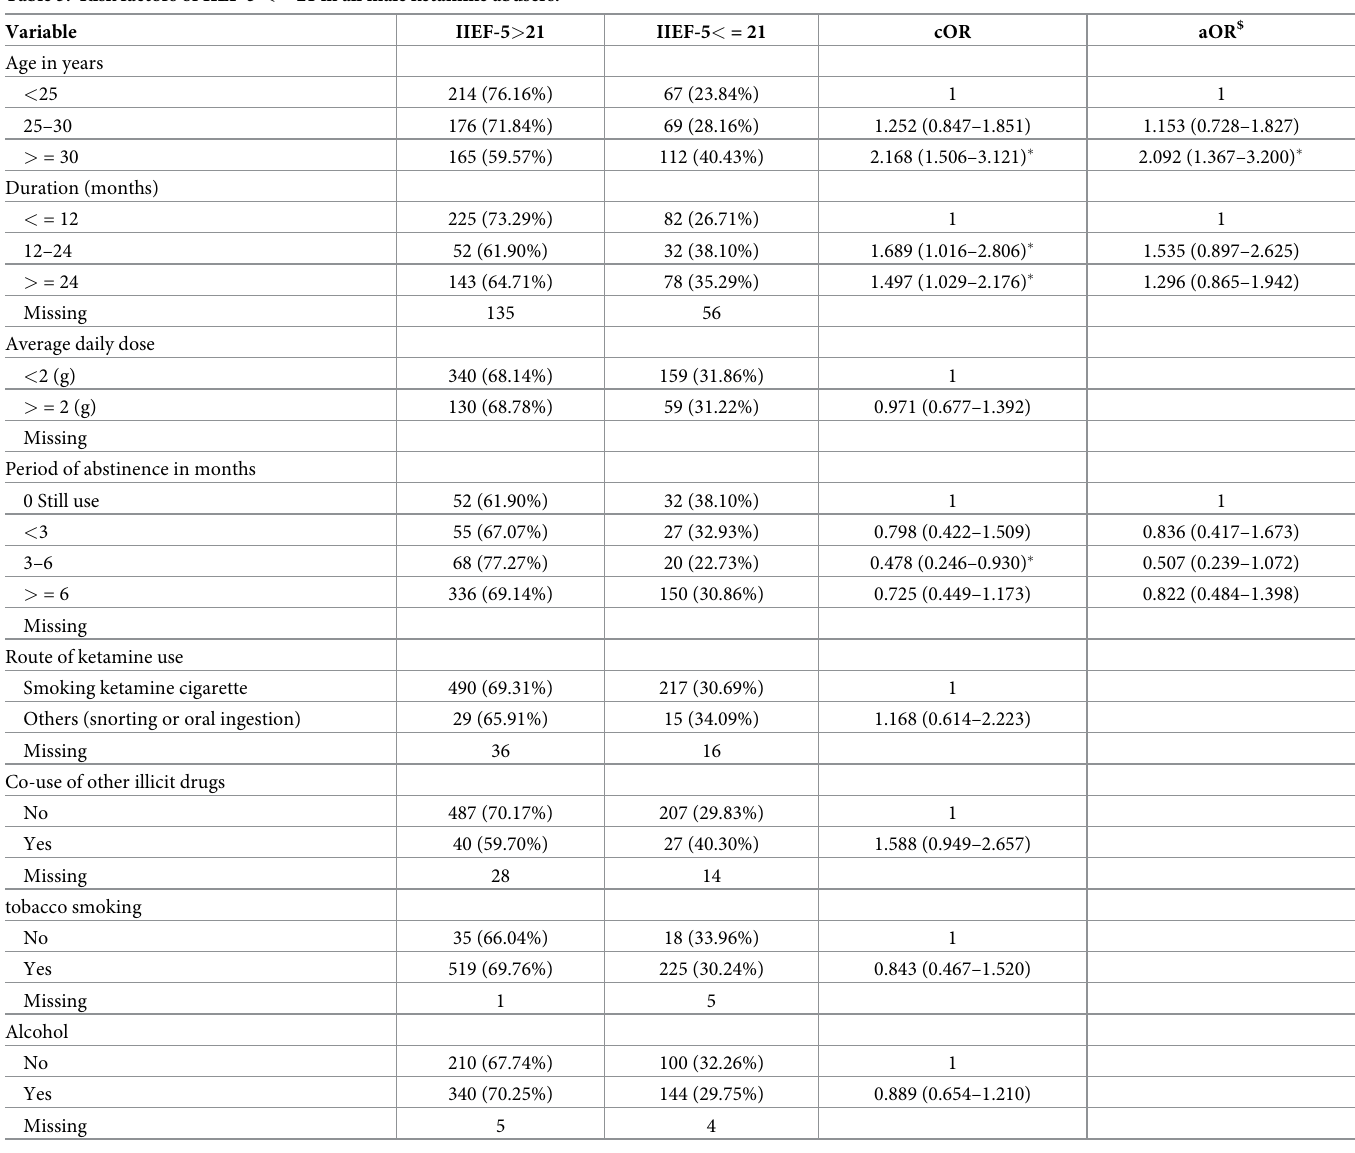
Table 3. Risk factors of IIEF-5 < = 21 in all male ketamine